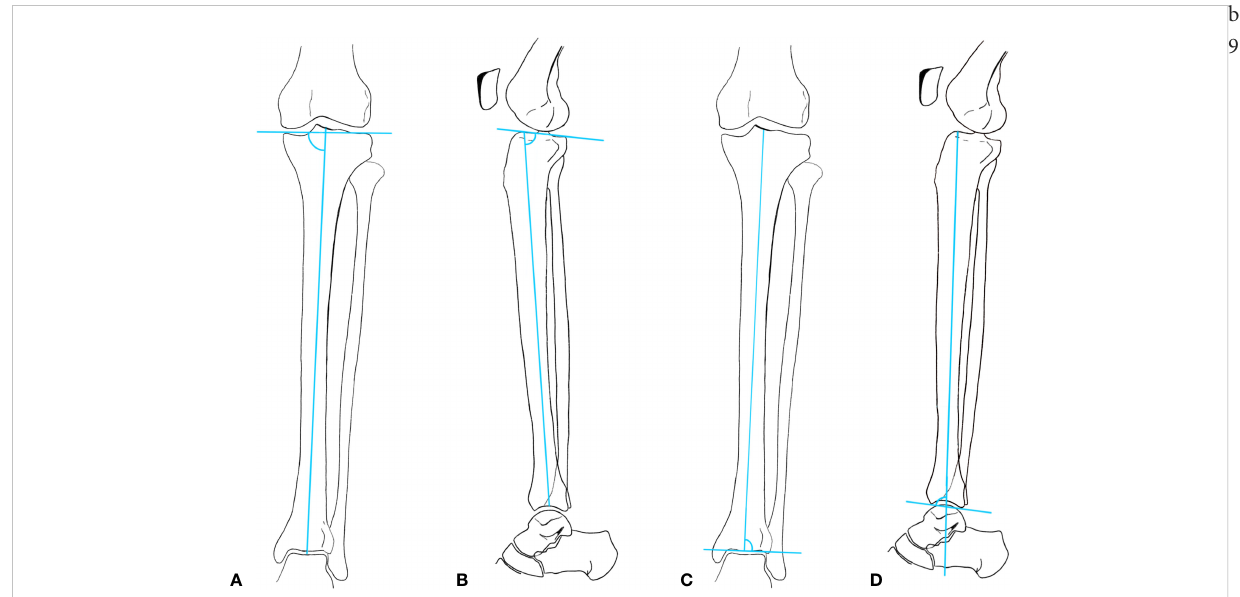
calcidiol levels within the normal range; decreased phosphate levels and elevated parathyroid hormone (PTH) values (Table 1). We did not fi nd a signi fi cant correlation between laboratory values and radiographic or gait analysis data. Phosphate, vitamin D and calcium therapy was actively taken